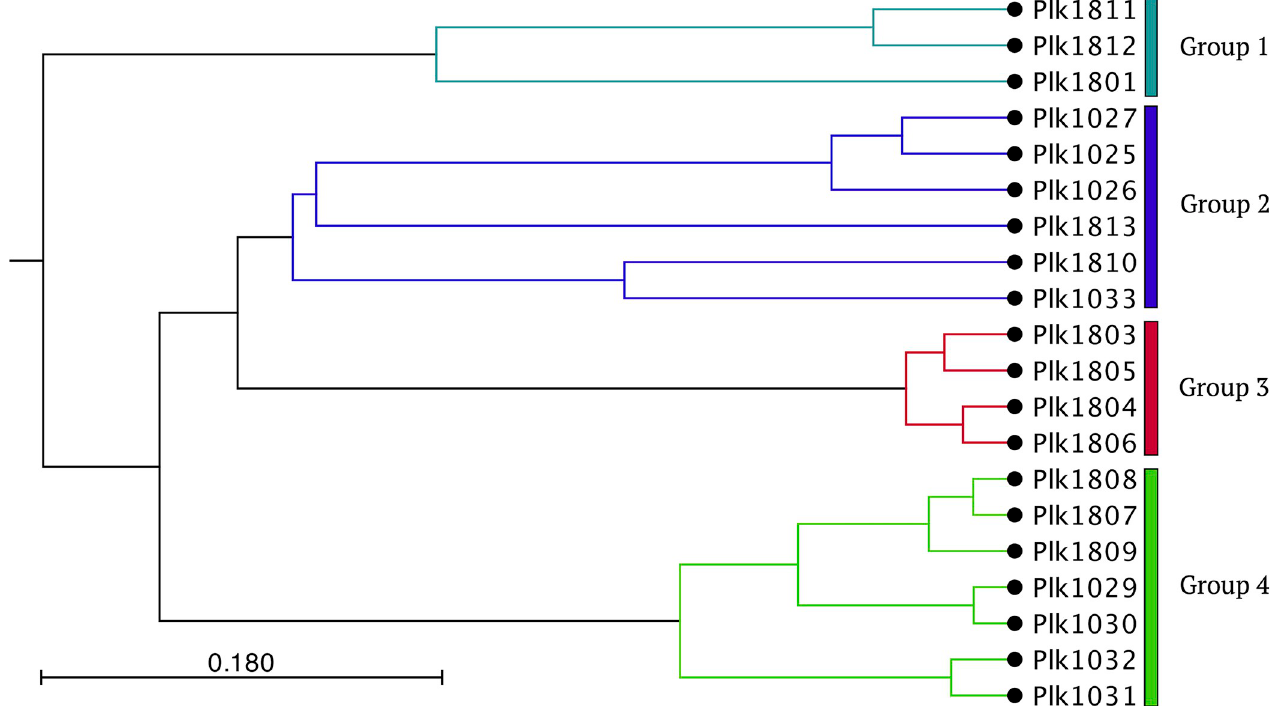
Fig 2. Whole genome phylogenetic tree based on (AP/ANI) reveals distinct grouping of P . agardhii isolates. Since the grouping is the same using either AP and ANI, only the tree generated using ANI and the UPGMA method is shown here. The bar represents the horizontal distance matrix used to scale the branch length as a function of substitutions per